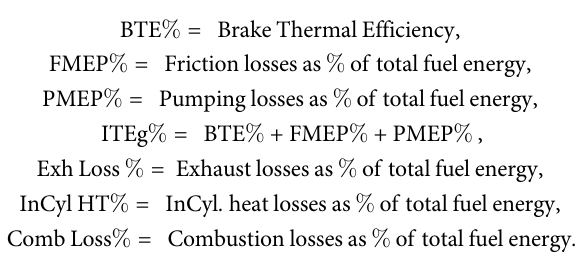
Frontiers in Mechanical Engineering |